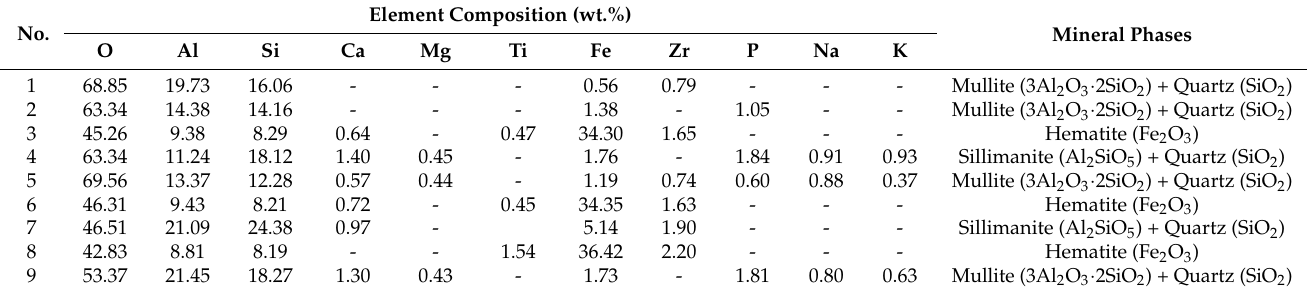
Table 3. Elemental chemical composition of various points in micro-zones A–D from Figure